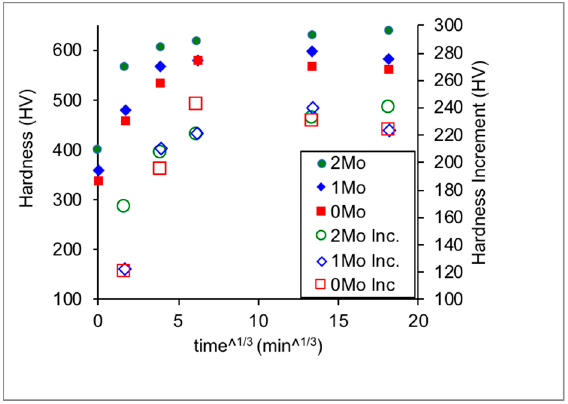
Figure 1. Hardness and incremental hardness during aging at 475 °C. The times included are 5 min., 1 h, 4 h, 40 h and 100 h.